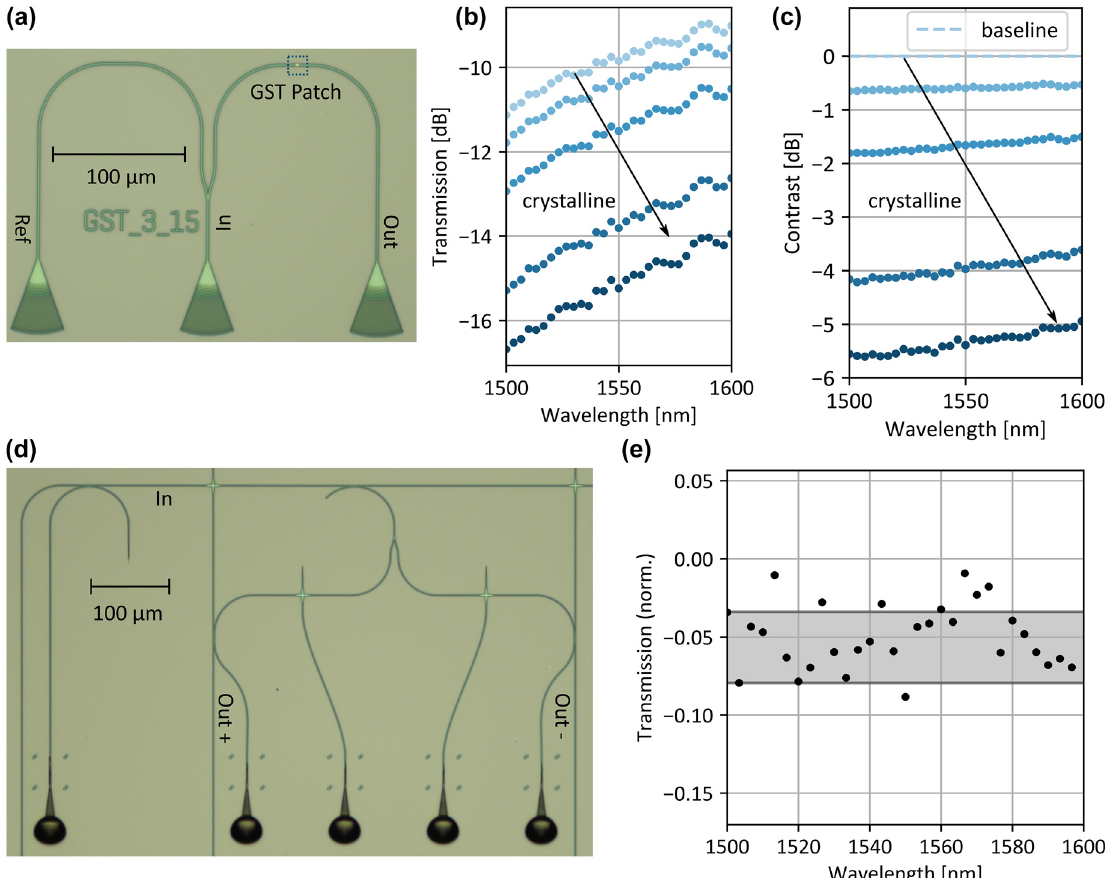
Figure 3: Photonic multiplication unit. (a) Basic photonic multiplication unit based on the phase change material GST. The multiplication is